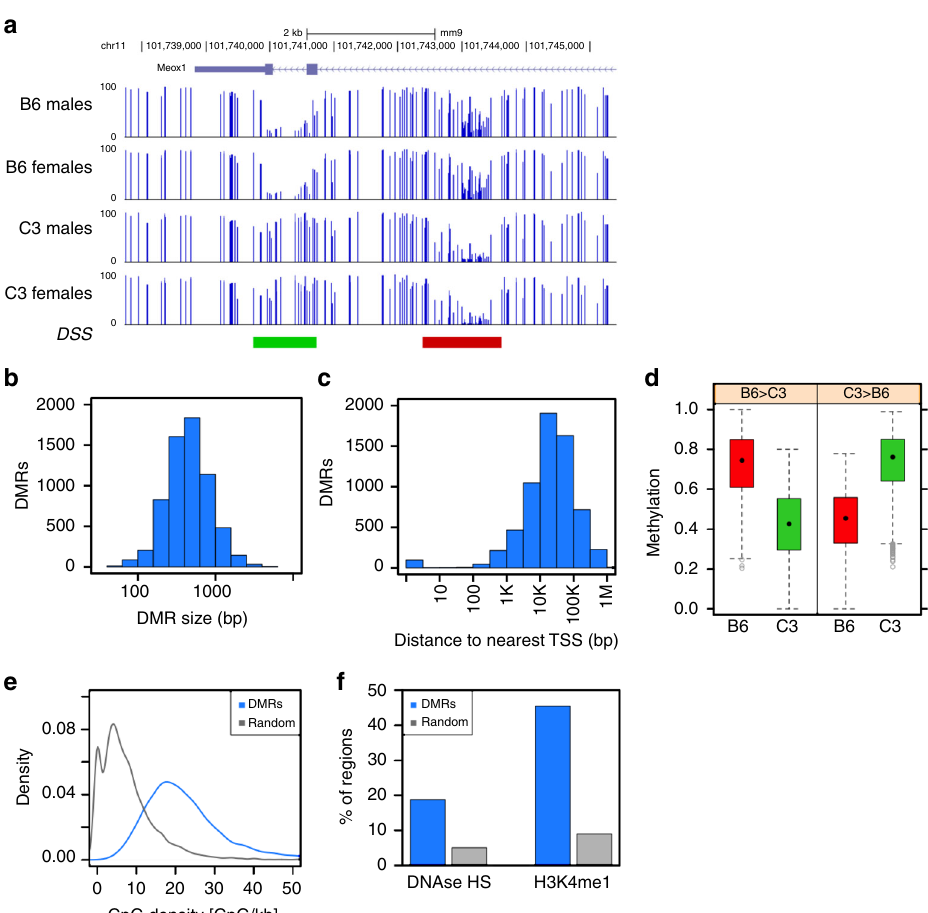
Fig. 2 DMRs between B6 ( n = 6) and C3 ( n = 6) parental animals, identi fi ed by DSS. a Genome browser view of example B6 > C3 DMR (red) and C3 > B6 DMR (green). b Distribution of DMR size, N = 6380. c Distribution of distance between DMR and nearest TSS (based on RefSeq gene models as of Feb 8, 2016), N = 6380. d Distribution of methylation level in DSS DMRs, by strain and DMR polarity. N = 3166 B6 > C3 DMRs and 3214 C3 > B6 DMRs. The box depicts the 25th to 75th percentiles (color by genotype where B6 is red and C3 is green), the black dot is the median, the whiskers extend to data points up to 1.5*IQR beyond the box, and open gray circles are data points outside the whisker range. e Distribution of CpG density at DSS DMRs ( N = 6380), compared to size-matched random genomic regions ( N = 6380). f Overlap of DSS DMRs ( N = 6380) with DNase hypersensitive sites (UCSC Genome Browser) and H3K4me1 enriched regions (ENCODE peaks ENCFF001XXZ), compared to the average overlap observed for 1000 iterations of